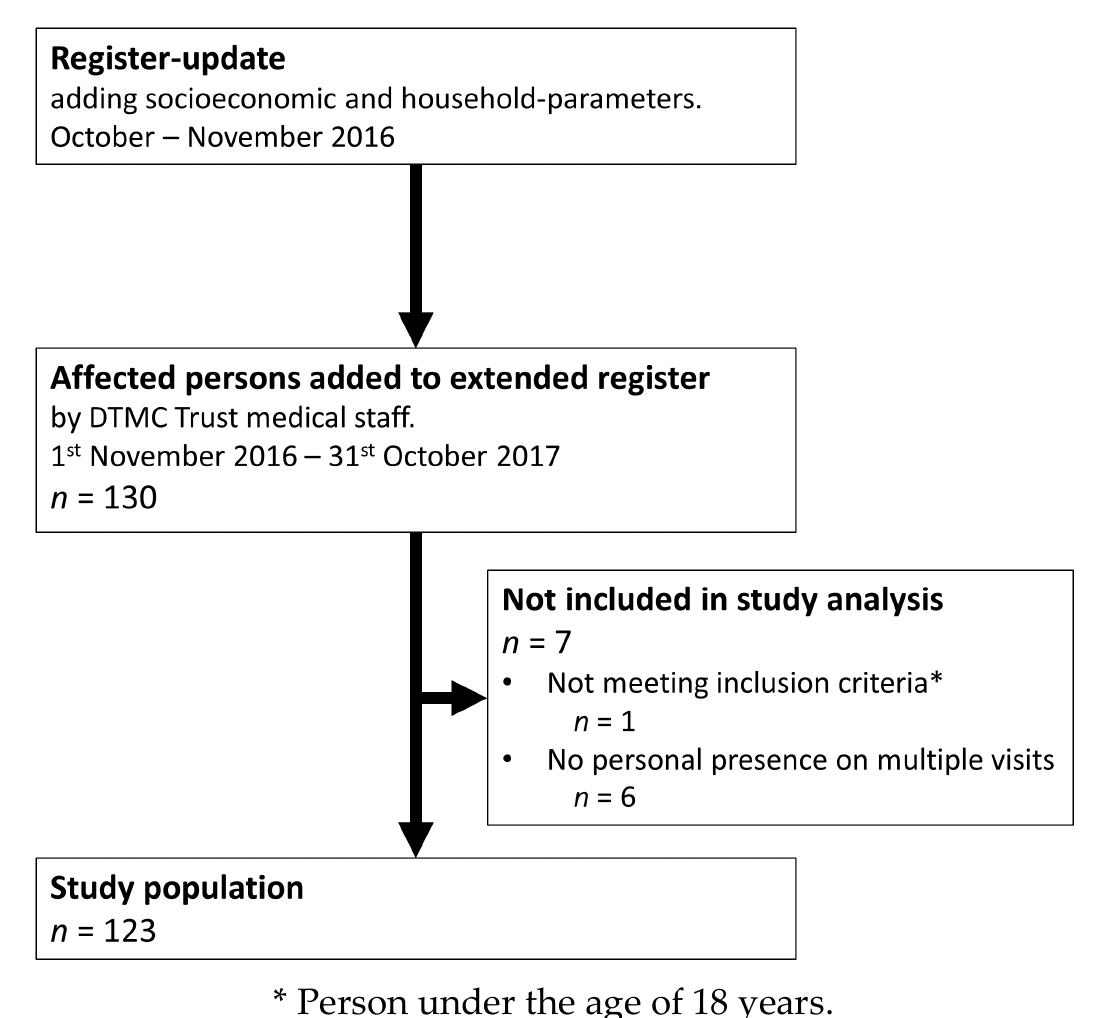
Figure 1. Flow diagram of the study and included leprosy-affected persons from the updated register of the Doctor Typhagne Memorial Charitable (DTMC) Trust.